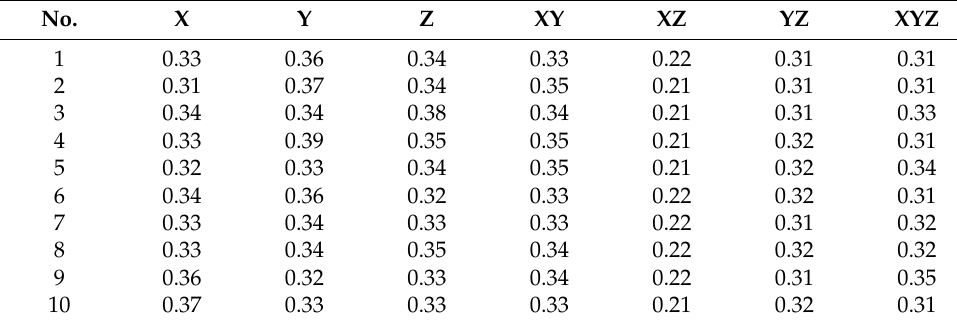
Table 12. CNN summary of ‘testing time’